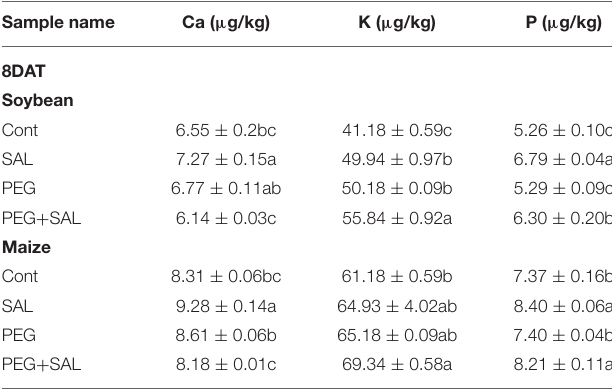
TABLE 2 | Macronutrient accumulation in soybean and maize plants grown under stress and control conditions with or without salvianolic